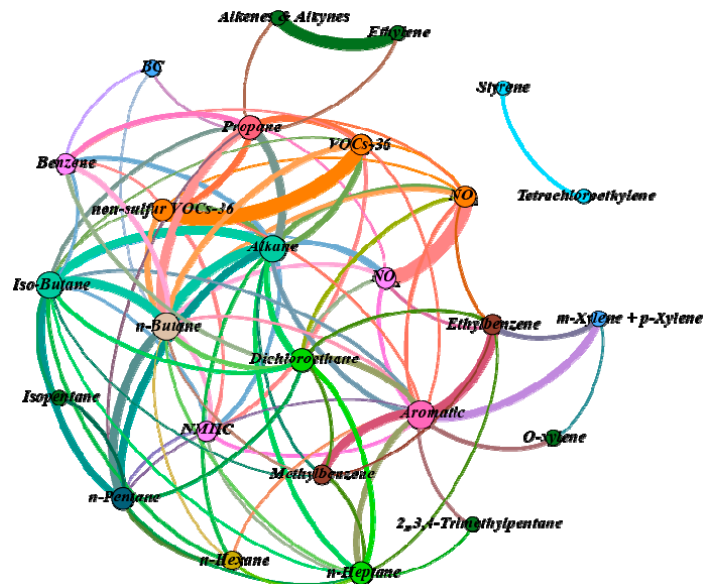
Figure 5. A Spearman analysis results.